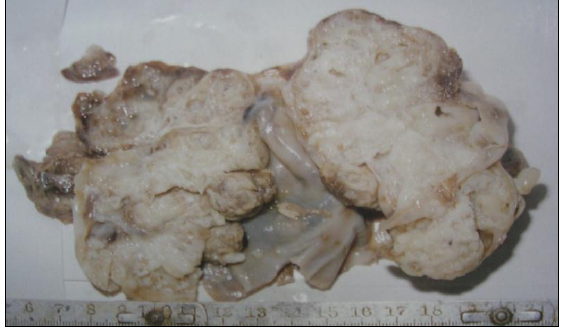
Figure 2: Cut surface of excised